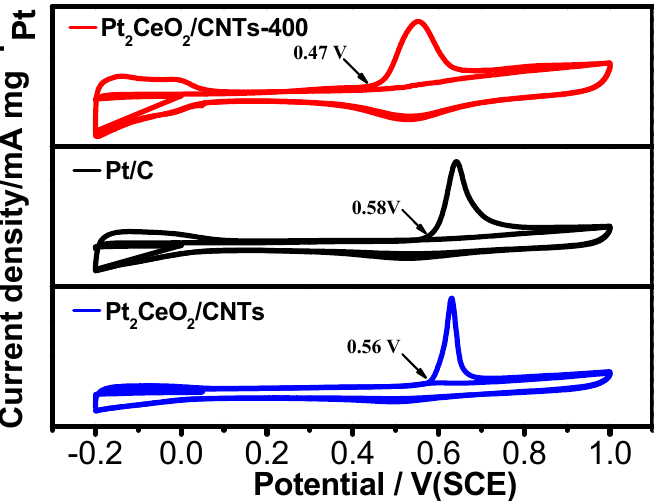
Figure 5. CO stripping voltammograms of Pt 2 CeO 2 /CNTs-400, Pt 2 CeO 2 /CNTs and Pt/C catalysts in 0.5 M H 2 SO 4 solution.